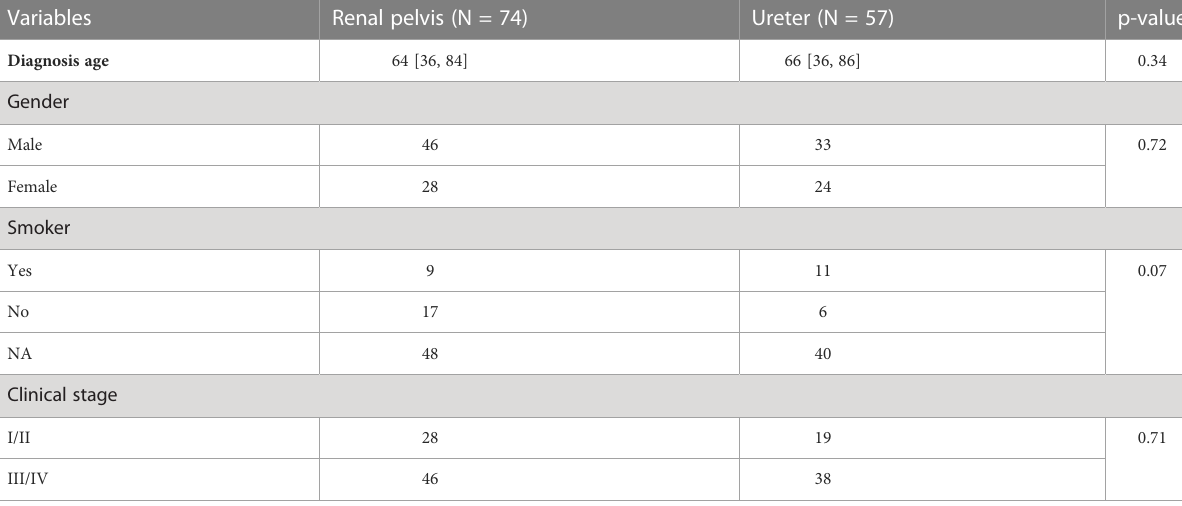
TABLE 3 UTUC patient (Renal pelvis & Ureter) characteristics in Chinese cohort.